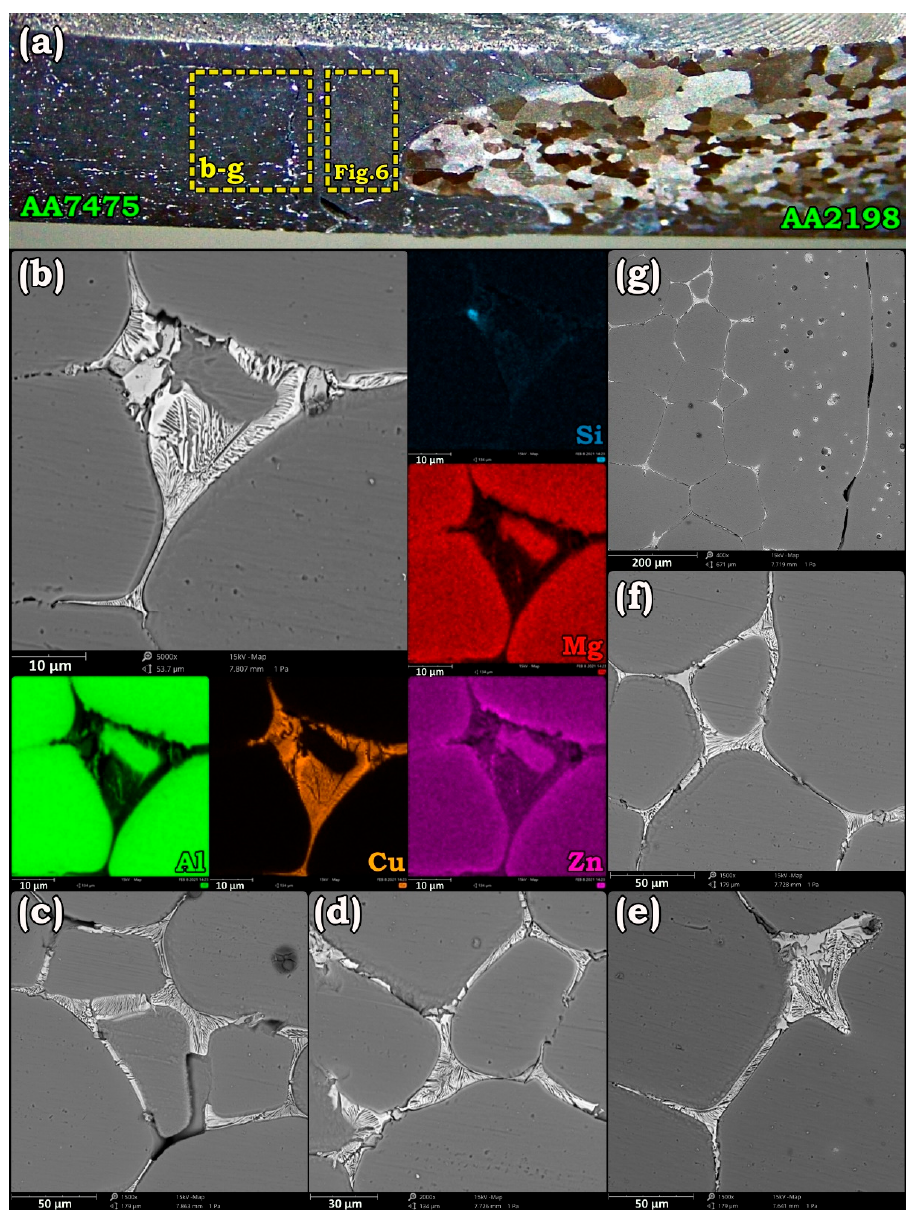
Figure 5. Stereo micrograph of solution treated AA7475-AA2198 sample ( a ) and formation of Cu-rich eutectic phases at GBs of AA7475 after annealing at 580 °C for 1 h ( b – g ).